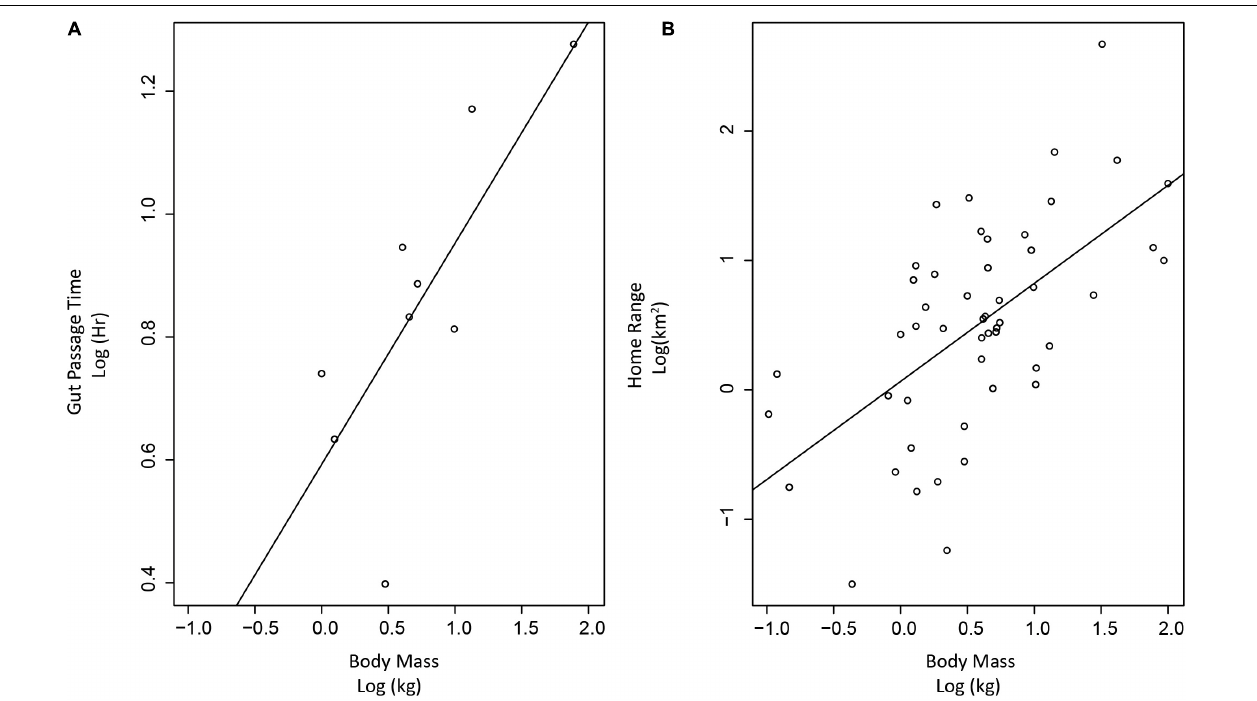
FIGURE 2 | Relationships between gut-passage time, home range, and body mass in Carnivorans . (A) Linear regression between the log body mass (kg) and log gut-passage time (hours) of 10 Carnivoran species ( p -value = 0.01, r-squared = 0.54). (B) Linear regression between the log mass (kg) and the log home range (km 2 ) of 51 Carnivoran species ( p -value < 0.001, r-squared value = 0.35). Gut-passage time, body mass, and home range values were derived from the available literature for species identified in our literature search as frugivorous Carnivorans ( Supplementary Table 5